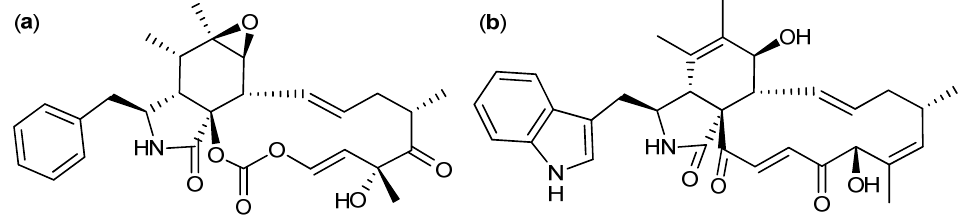
Figure 22. ( a ) Cytochalasin E and ( b ) Chaetoglobosin B.